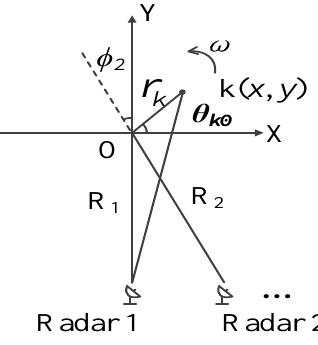
Figure 1. Geometry of distributed inverse synthetic aperture radar (ISAR).